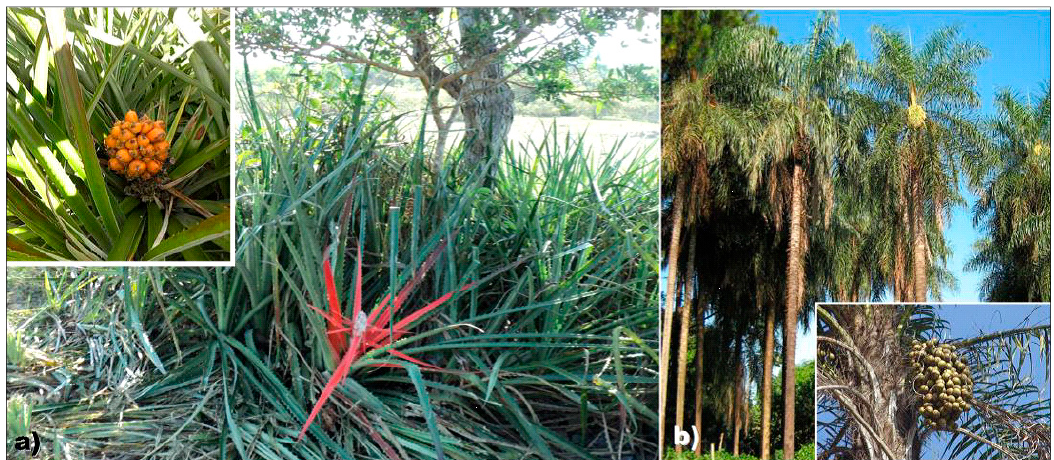
Figure 1. Images of ( a ) gravata and ( b ) macauba, with their respective fruits in detail.